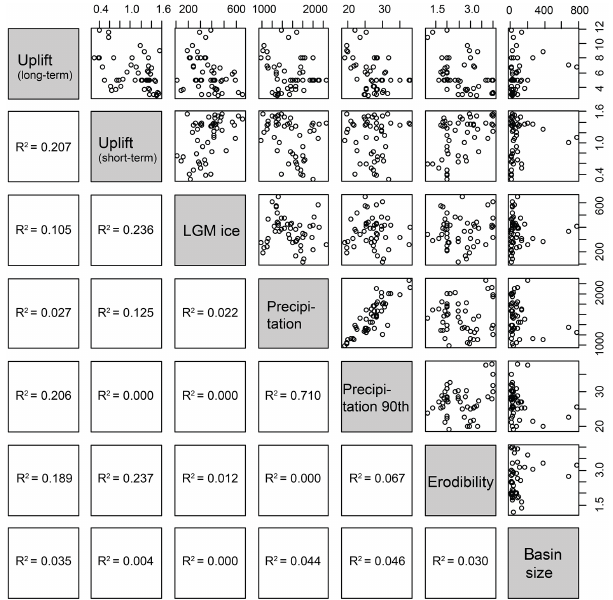
Figure 7. Correlation matrix of the possible controlling variables uplift (short- and long-term), precipitation (annual mean and 90th percentile), LGM ice thickness and erodibility. The strength of cor- relation for each pair is given by the square of the correlation coef- ficient, r 2 .